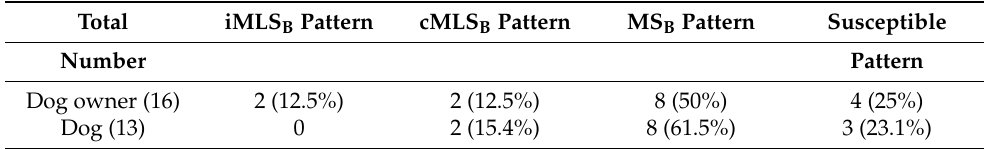
Table 5. Inducible and constitutive MLS B pattern in dogs and dog